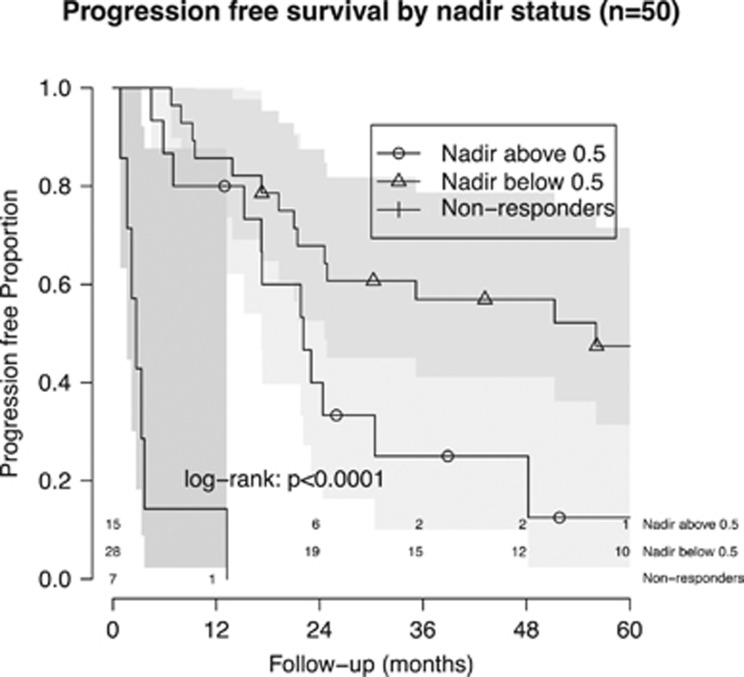
Progression-free survival by nadir status.